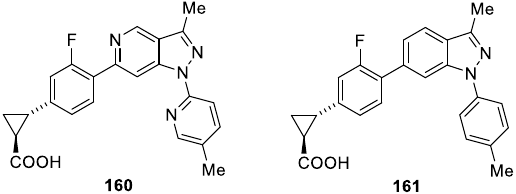
Figure 46. Chemical structures of 1 H -indazole derivatives 160 and 161.